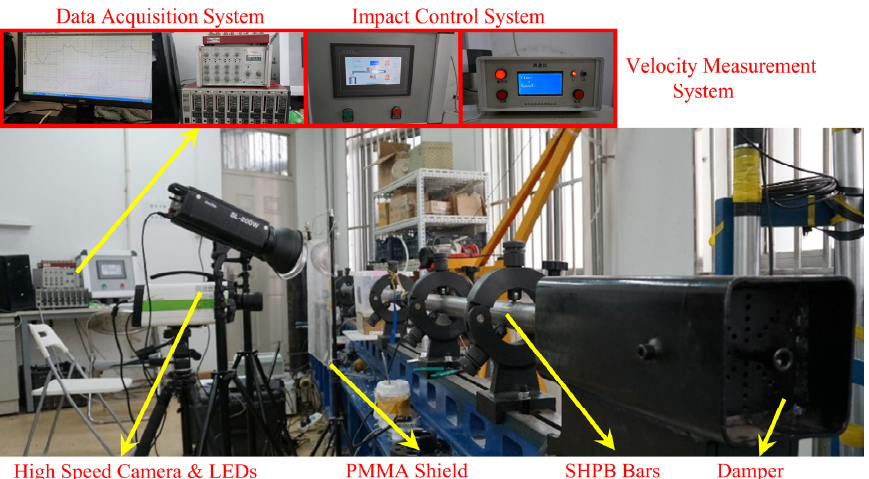
Figure 1. Layout of experimental